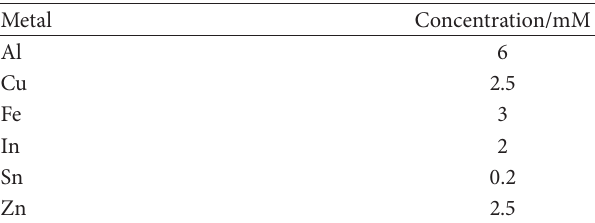
Table 3: Metal composition of the aqueous phase before extraction.